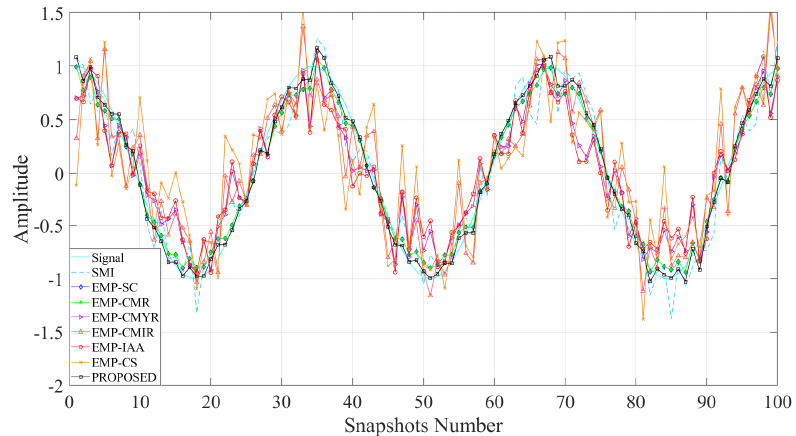
Figure 3. Comparison of array output data.